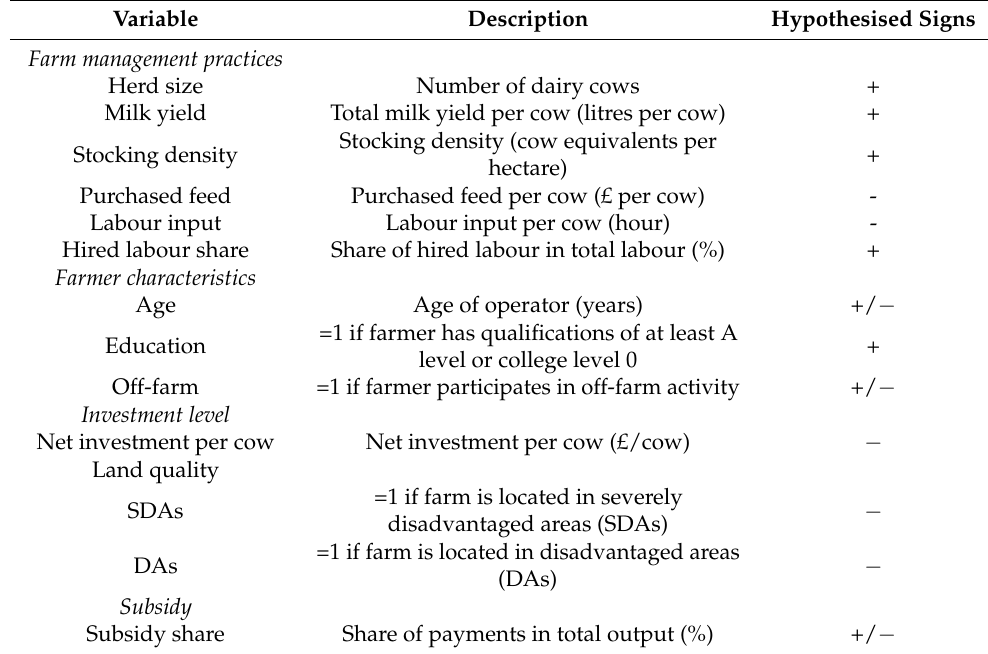
Table 1. Variable descriptions and hypothesised